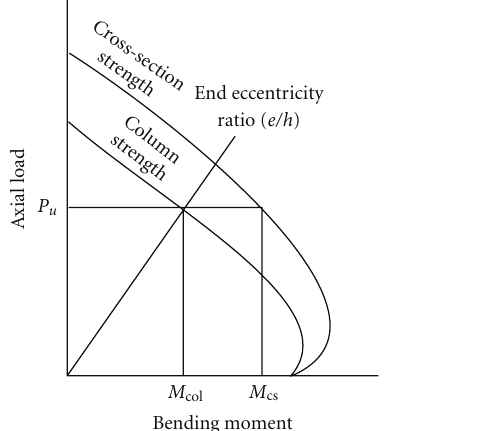
Figure 14: Schematic cross-section and column axial load-bending moment interaction curves used for CSA